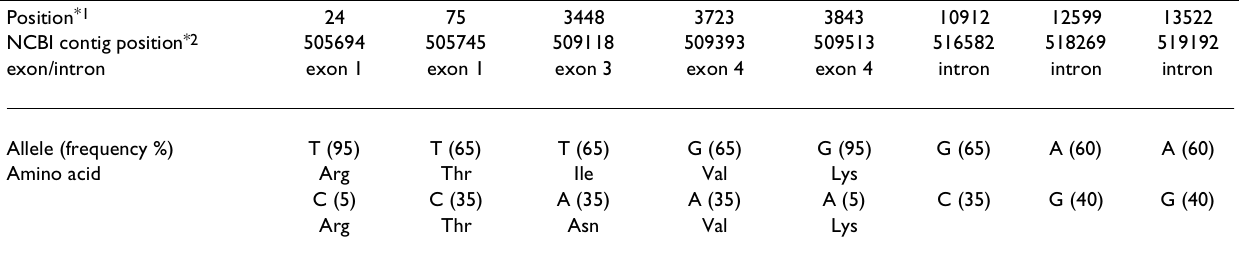
*1 The positions were counted from the ATG initiation codon of the IHRP gene. *2 The NCBI contigs were derived from assembled genomic sequence data of locus NT_005986.